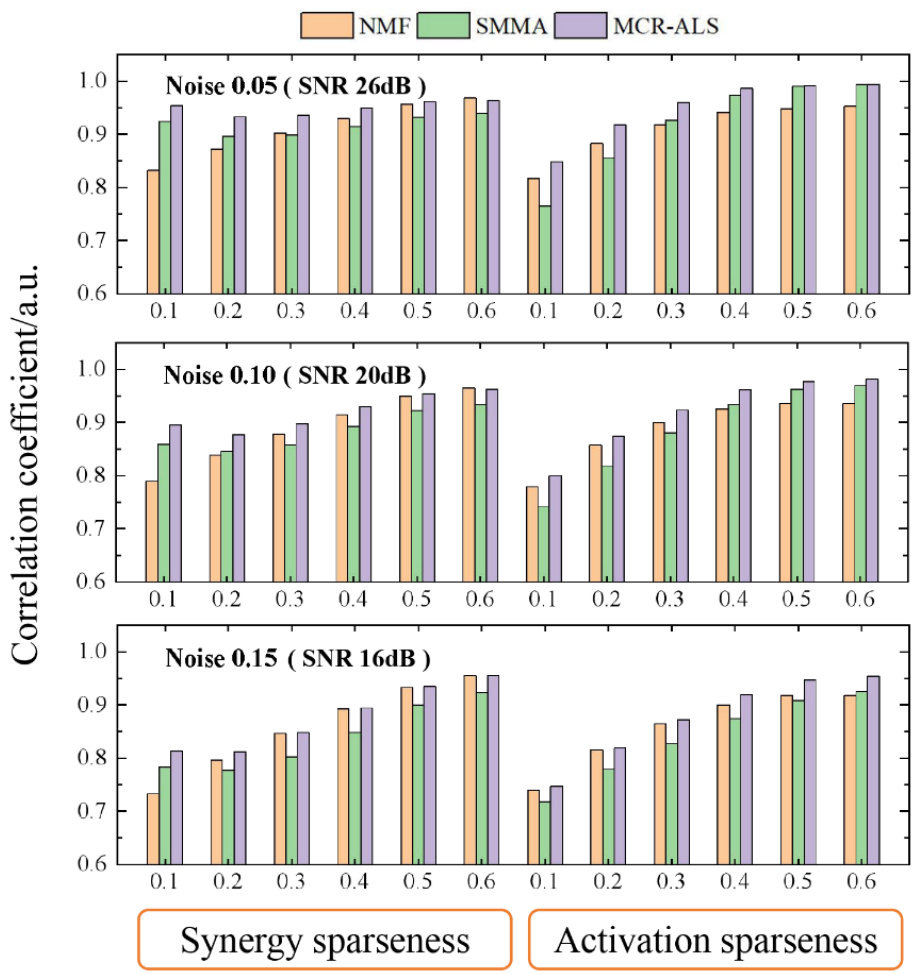
Figure 4. Average correlation coefficients for the fully identified synergies compared across two settings (sparseness, noise) for the three methods.